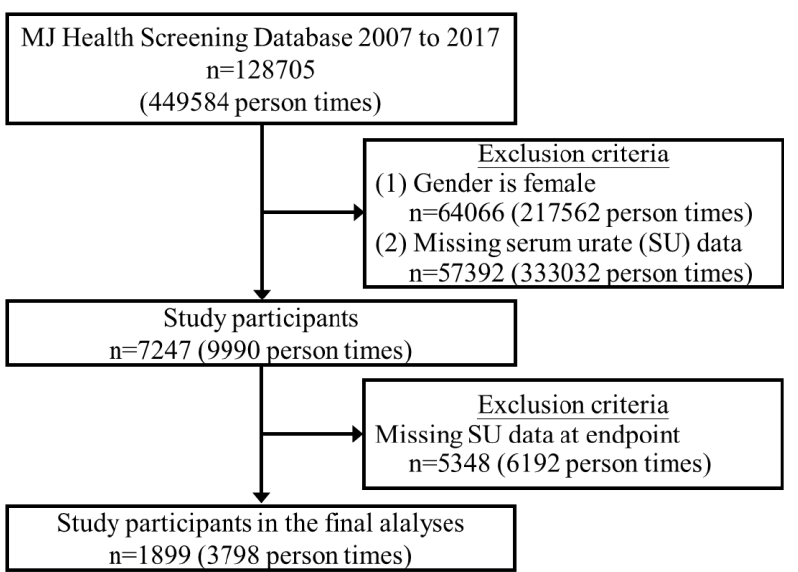
Figure 1. Flowchart of the sampling frame and participant section from the study database.